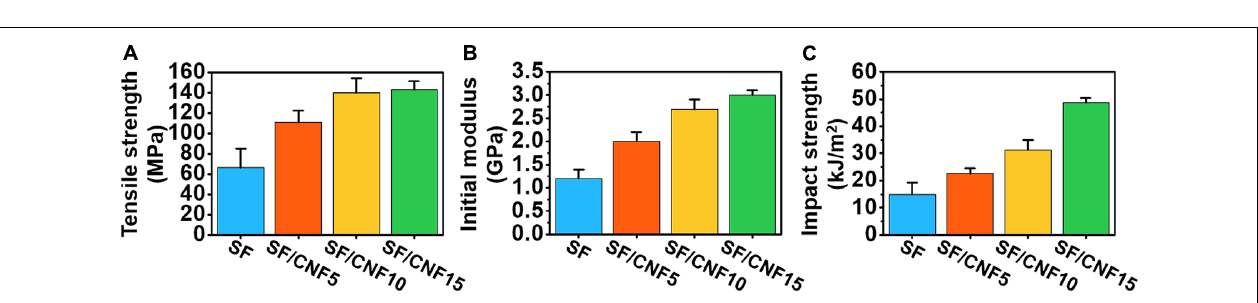
FIGURE 7 | Mechanical properties of nonwoven SF and SF/CNF composites with various amounts of CNFs: (A) tensile strength, (B) tensile modulus, and (C) impact strength.